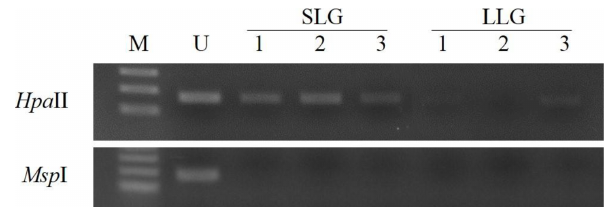
Figure 2. Methylation analysis of the ZPBP gene in whole blood samples of Berkshire sows by PMP assay. gDNAs were cut with the methylation-sensitive restriction enzymes Hpa II/ Msp I. M: size marker; U: undigested DNA; SLG: smaller litter size group; LLG: larger litter size